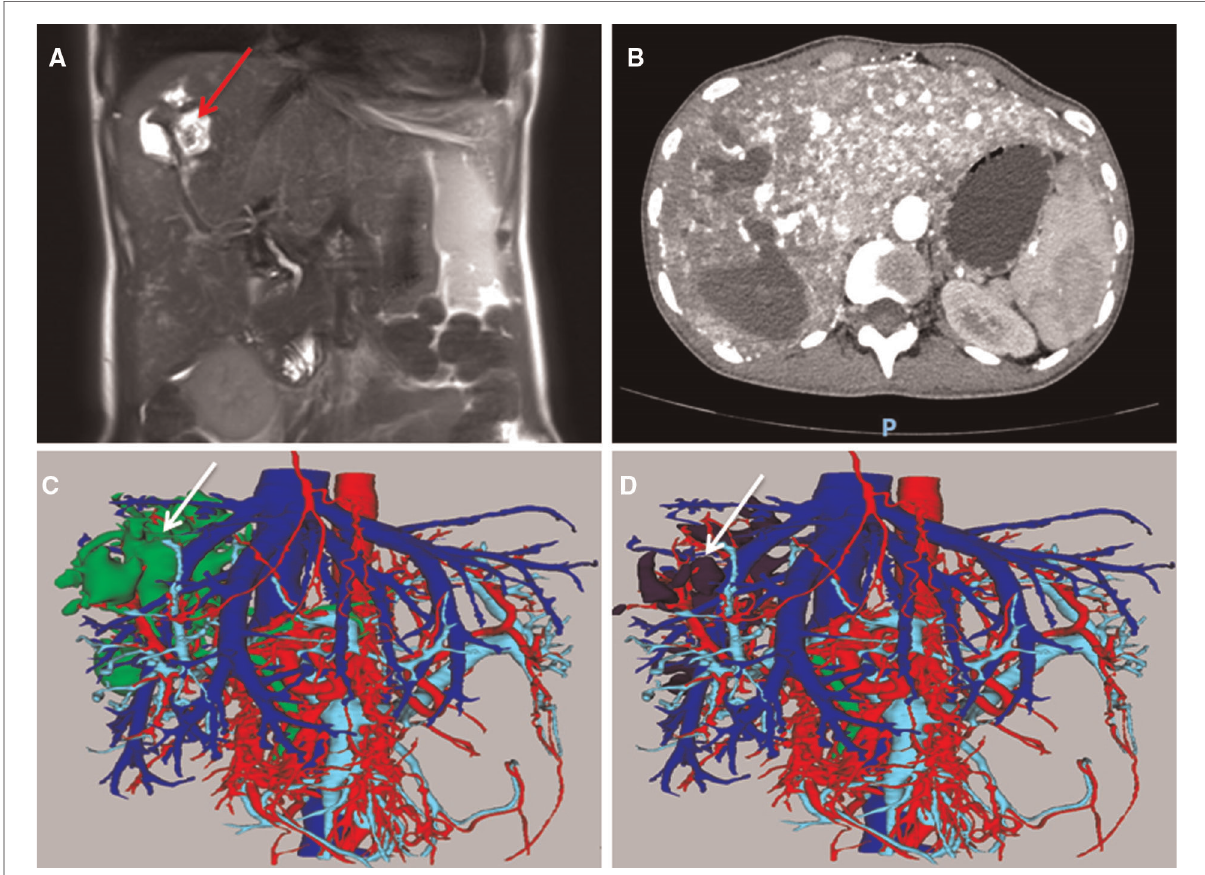
FIGURE 1 Imaging of HHT involvement in the liver. ( A ) The MRI results suggested right hepatobiliary dilatation with stone formation (arrow); ( B ) The arterial phase of CT indicated diffuse telangiectasia and shunting in the liver; ( C ) Three-dimensional reconstruction showed hepatic telangiectasia and bile duct dilatation (arrow); ( D ) Three-dimensional reconstruction showed telangiectasia and intrahepatic bile duct stones